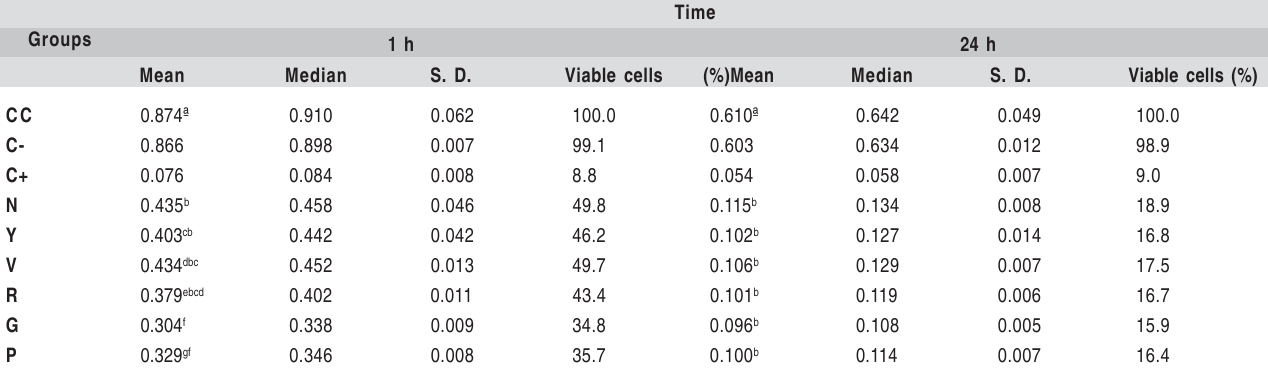
Table 2. Descriptive statistics for optical density of latex